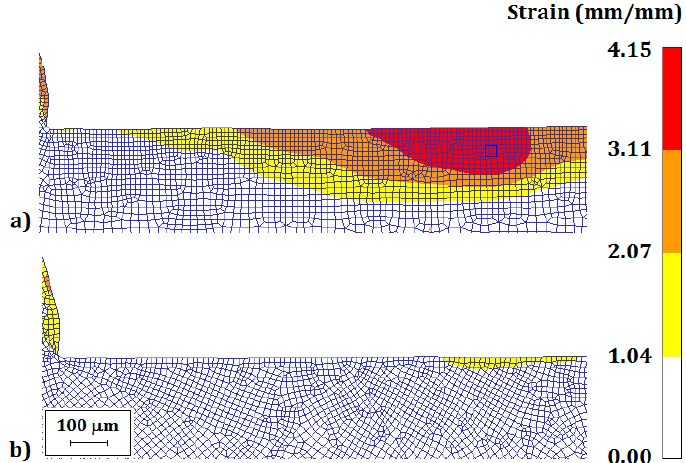
Figure 4. Grain size prediction: overall results (NH-W: negative rake worn insert, NH-F: negative rake fresh insert, UP-W: positive rake worn insert and UP-F: positive rake fresh insert). Appl. Sci. 2019 , 9 , x FOR PEER REVIEW